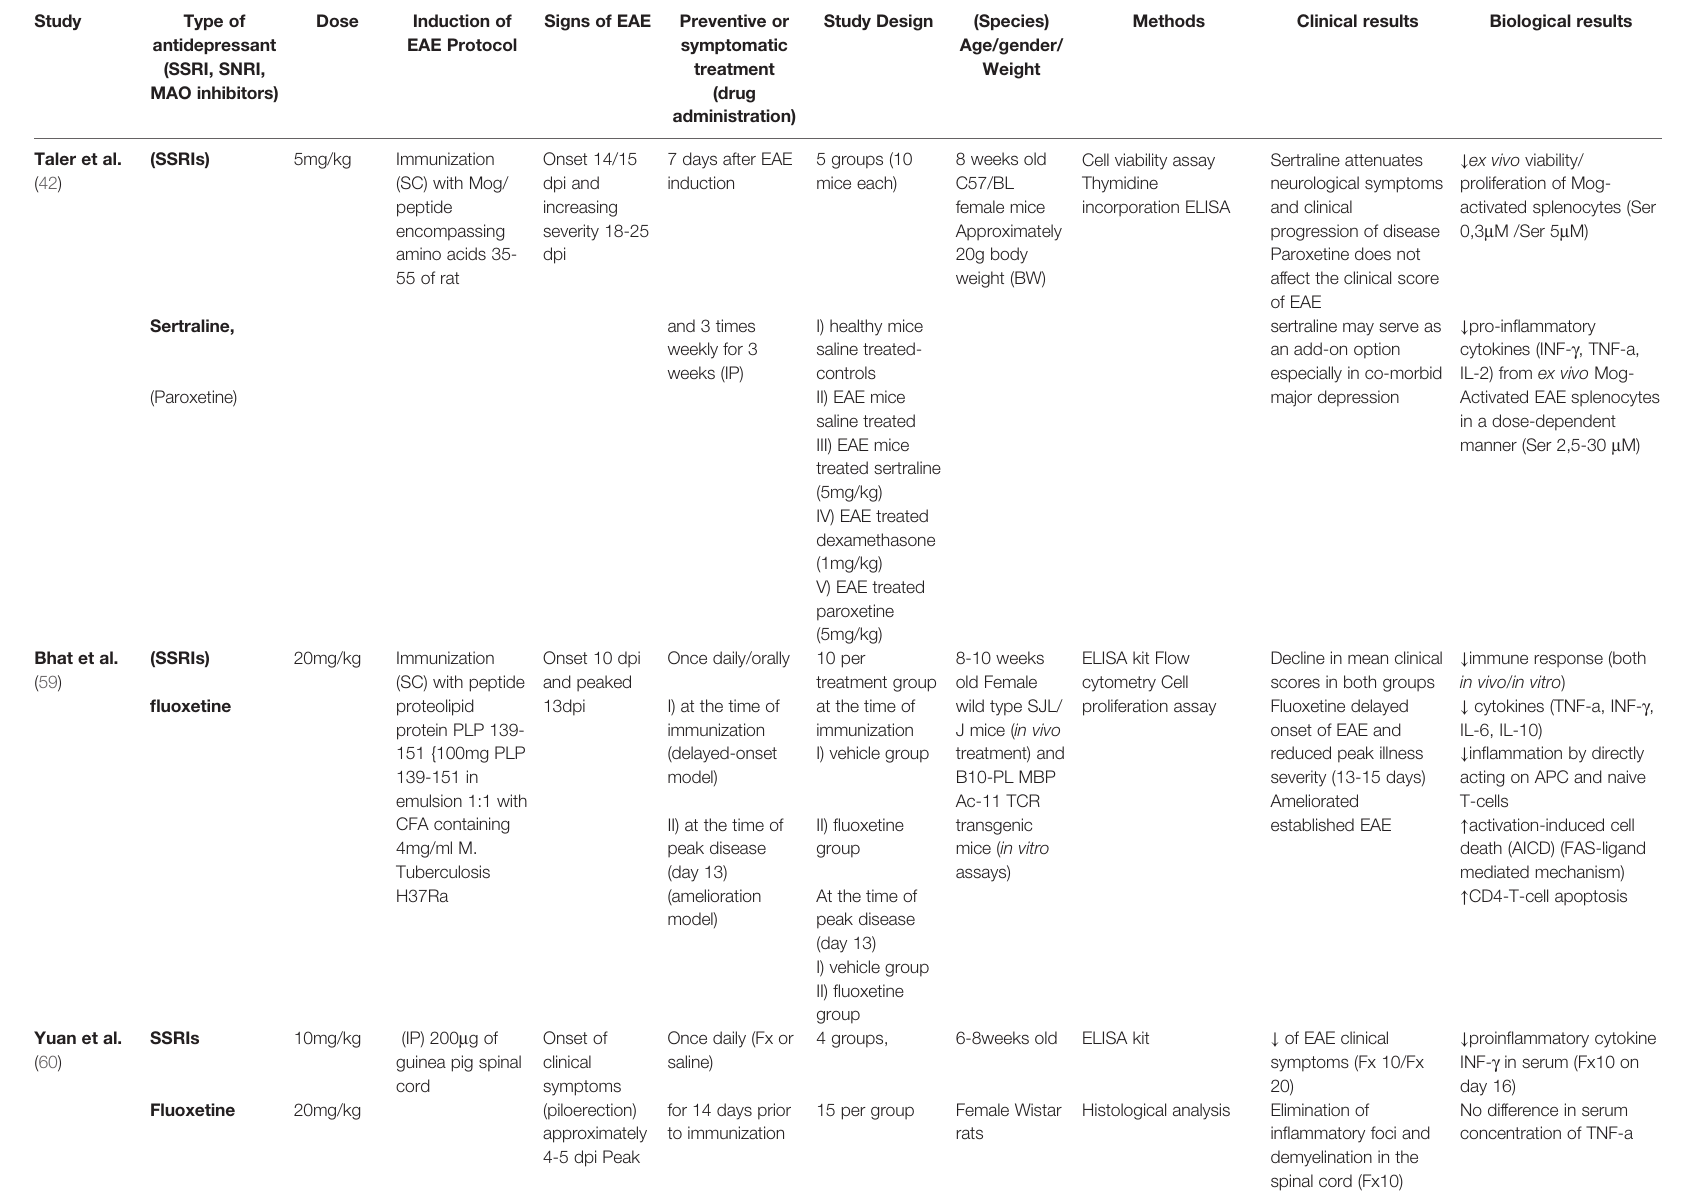
TABLE 2 | Comparative assessment of in vivo studies on the effects of antidepressants on disease scores and